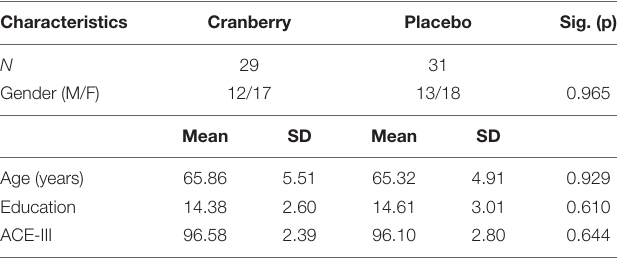
TABLE 1 | Demographic characteristics of the subjects at inclusion ( n =